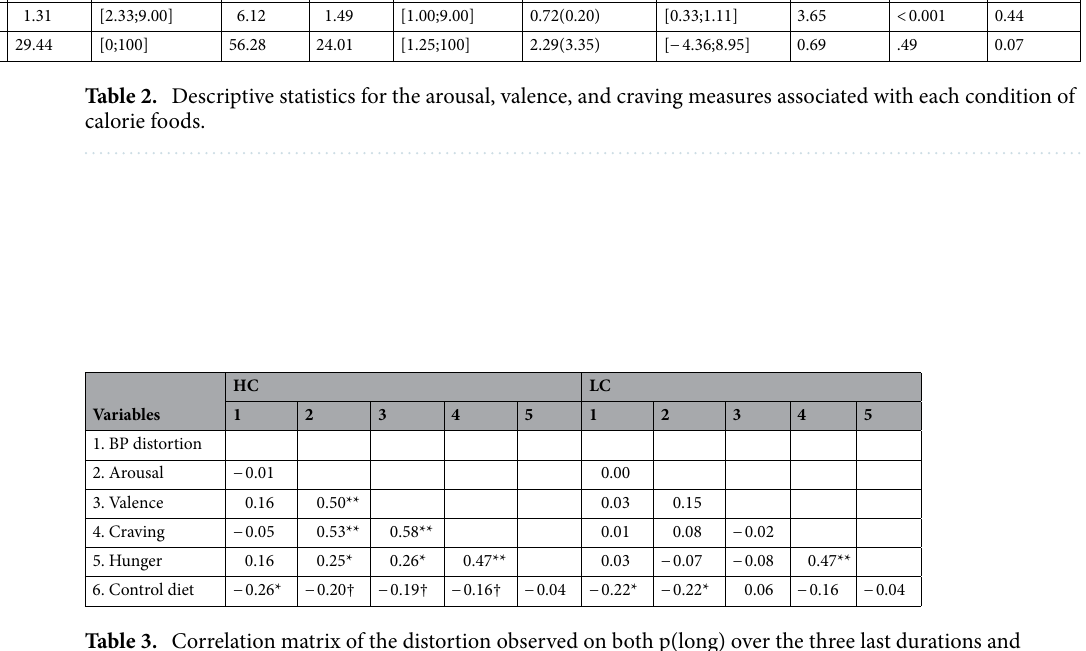
Table 3. Correlation matrix of the distortion observed on both p(long) over the three last durations and Bisection Points, as well as on the variables of Arousal, Valence, Craving, Hunger, and Control Diet, each of which are measures associated with the high and low control conditions. Note: †p < 0.01; *p < 0.05; **p <